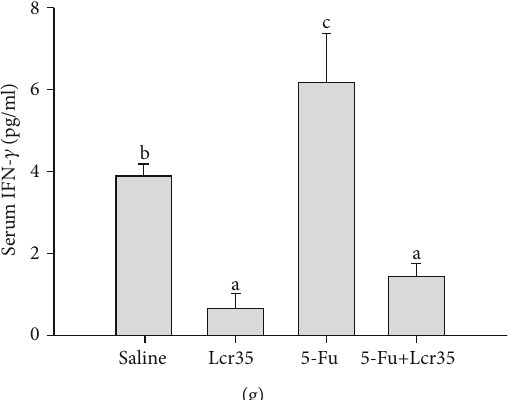
Figure 3: Upregulations of IL-1 β , IL-4, IL-6, IL-17A, MCP-1, TNF- α , and IFN- γ in mucositis mice were shown after 5-FU injection. IL-6, IL- 1 β , and TNF- α serum levels were measured by the panel kit. (a) The serum IL-1 β level in the 5-FU+Lcr35 group ( 35 : 8 ± 6 : 1ng/ml ) was signi fi cantly lower than that in the 5-FU group ( 95 : 8 ± 8 : 0ng/ml ) ( p = 0 : 0001 ). (b) The serum IL-4 level in the 5-FU+Lcr35 group ( 0 : 97 ± 0 : 06 ng/ml ) was signi fi cantly lower than that in the 5-FU group ( 1 : 95 ± 0 : 34 ng/ml ) ( p = 0 : 004 ). (c) The serum IL-6 level in the 5- FU+Lcr35 group ( 0 : 69 ± 0 : 23ng/ml ) was signi fi cantly lower than that in the 5-FU group ( 2 : 53 ± 0 : 62ng/ml ) ( p = 0 : 003 ). (d) The serum IL-17A level in the 5-FU+Lcr35 group ( 4 : 35 ± 0 : 35 ng/ml ) was signi fi cantly lower than that in the 5-FU group ( 7 : 50 ± 0 : 78ng/ml ) ( p = 0 : 003 ). (e) The serum MCP-1 level in the 5-FU+Lcr35 group ( 67 : 1 ± 3 : 8ng/ml ) was signi fi cantly lower than that in the 5-FU group ( 94 : 1 ± 14 : 2 ng/ml ) ( p = 0 : 04 ). (f) The serum TNF- α level in the 5-FU+Lcr35 group ( 52 : 2 ± 4 : 9ng/ml ) was signi fi cantly lower than that in the 5-FU group ( 116 : 9 ± 14 : 7 ng/ml ) ( p = 0 : 001 ). (g) The serum IFN- γ level in the 5-FU+Lcr35 group ( 1 : 45 ± 0 : 31ng/ml ) was signi fi cantly lower than that in the 5-FU group ( 6 : 16 ± 1 : 21ng/ml ) ( p = 0 : 0001 ). Statistical analyses were performed by one-way